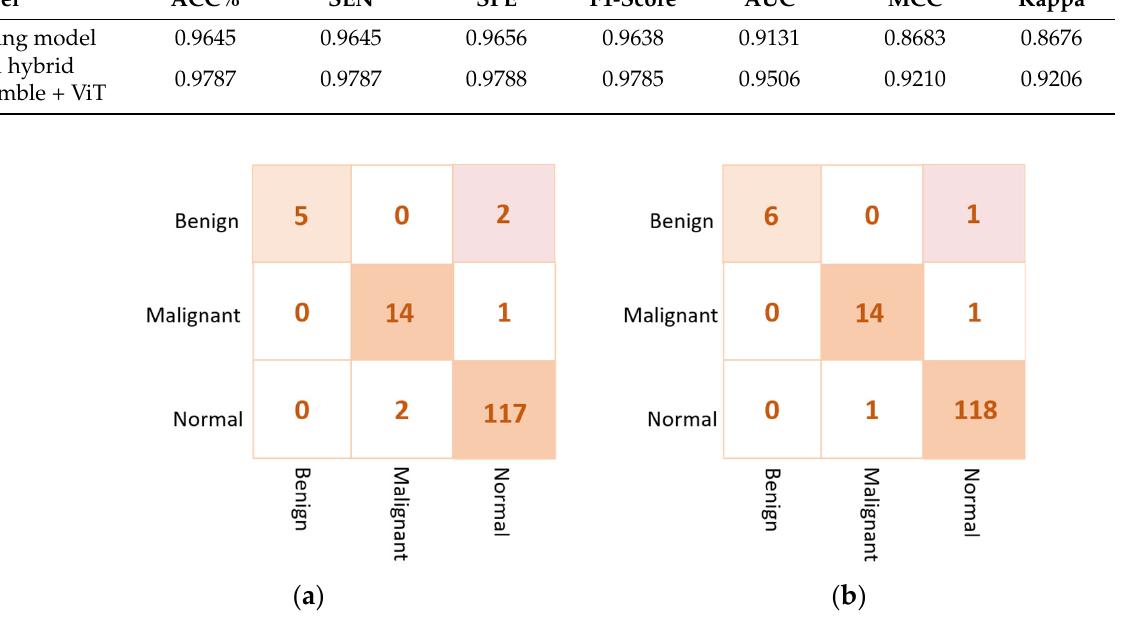
Figure 10. Confusion matrix of the proposed AI models for the multi-class classification approach. ( a ) The Ensemble learning model ( b ) the proposed ETECADx. Table 7. Evaluation performance of the proposed ETECADx framework against the ensemble learn- ing model for the multi-class classification approach using the INbreast testing set.